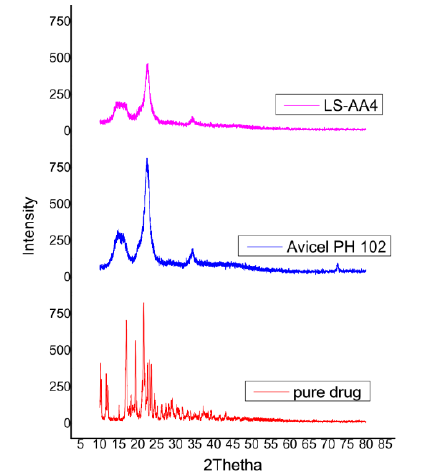
Figure 2. XRD diffractogram of the liquisolid tablet AA4, Avicel PH 102, and pure drug atorvastatin calcium powder.